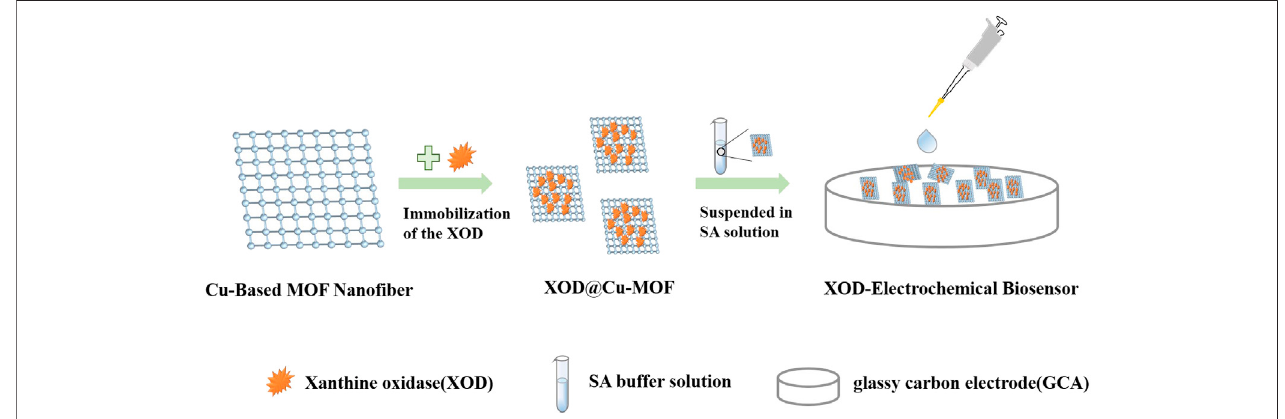
FIGURE 3 | The fabrication of XOD-electrochemical